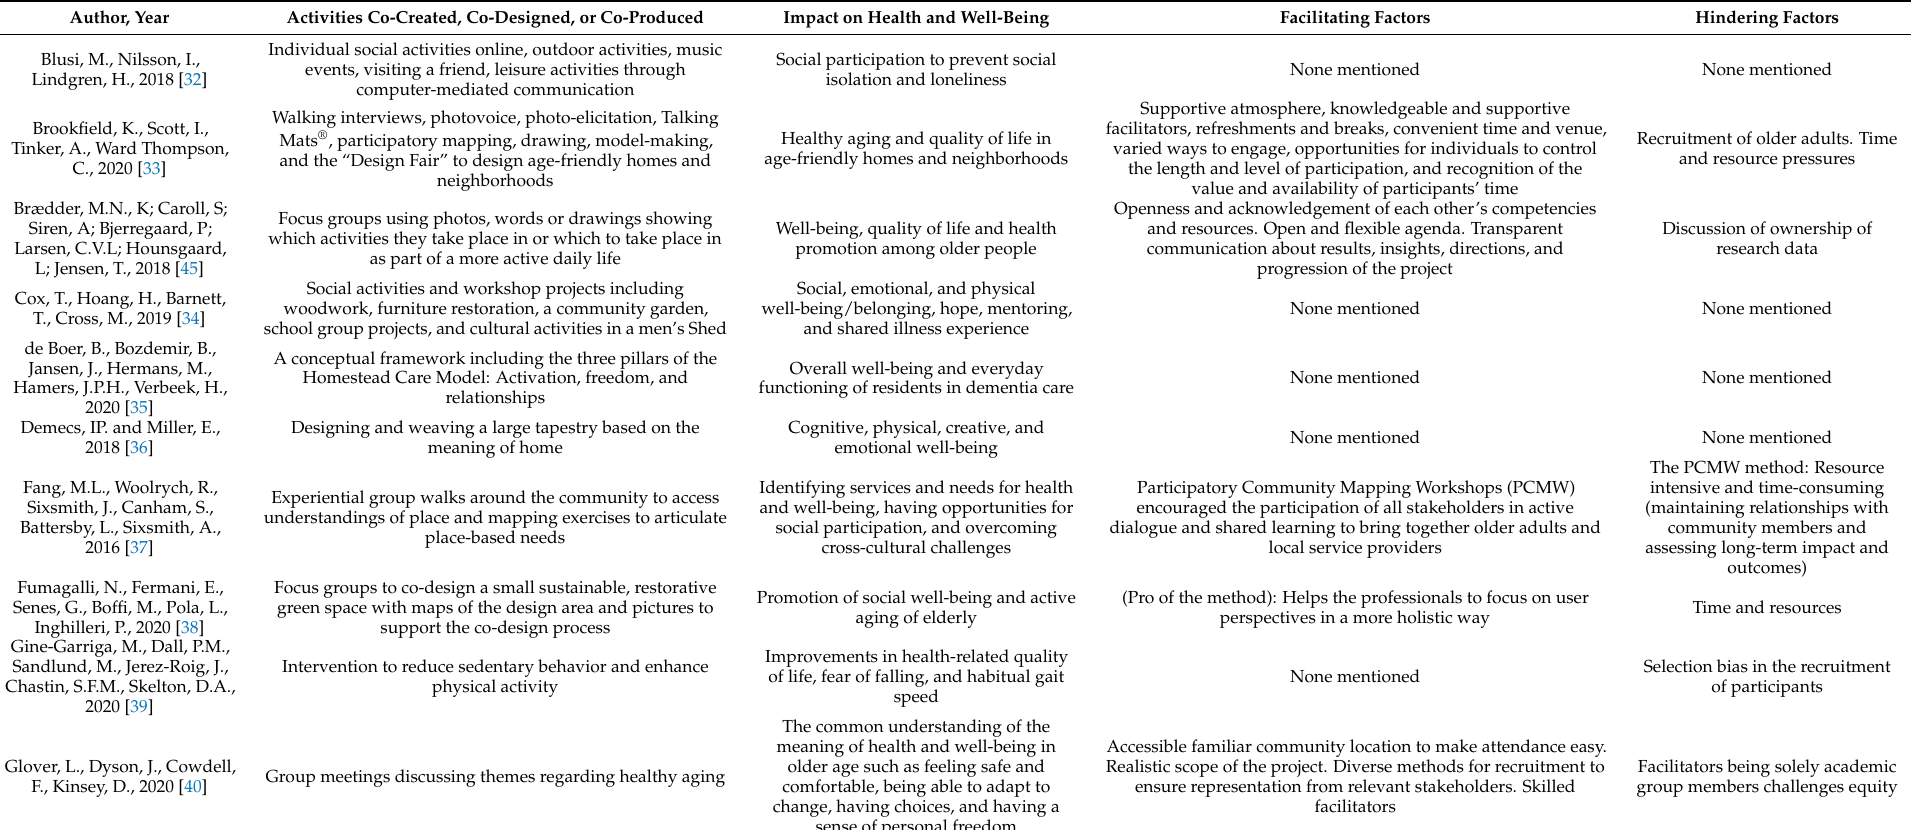
Table A2. Activities co-created/co-designed/co-produced, impact on health and well-being, and influencing